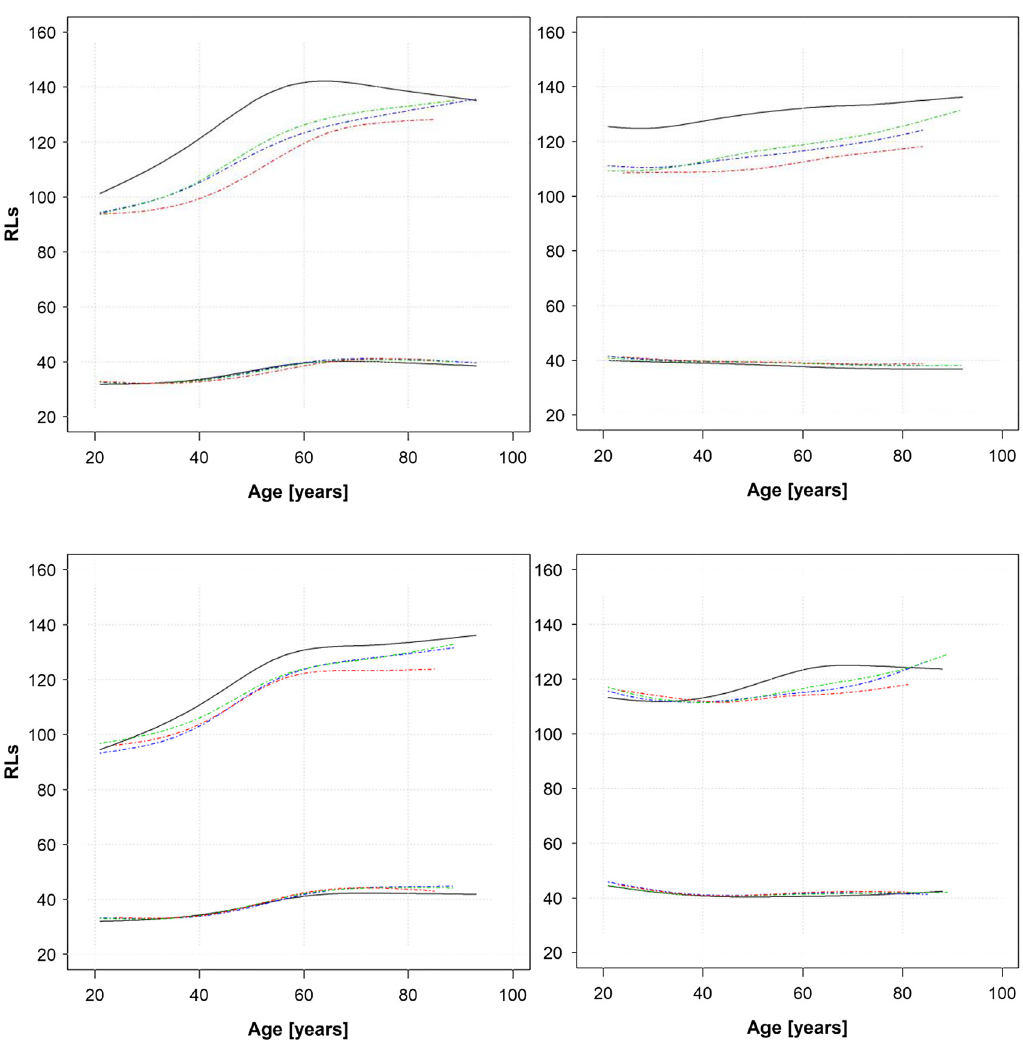
Figure2: Comparingofestimatedage-dependentlower/upperRLsforAPvaluesthroughall(black),first(blue),last(green)andnon-repeated (red) subpopulations for adult. Left: female and right: for male subjects. Above via data from UKK (Hospital C) and bottom via data from laboratory